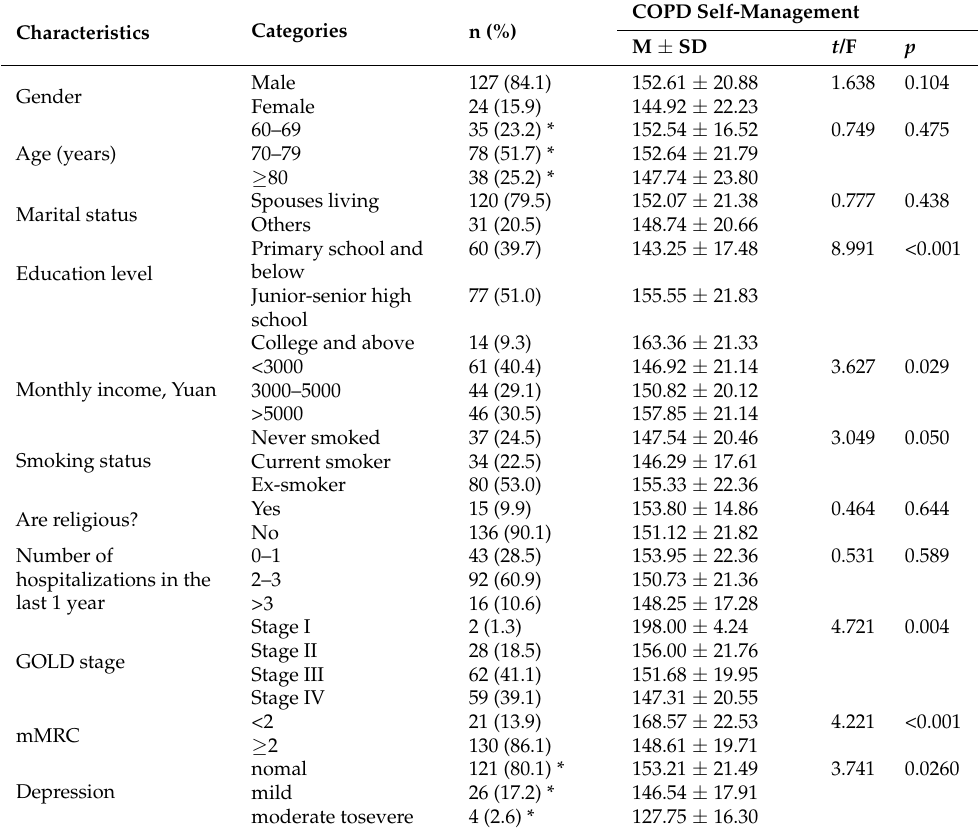
Table 1. Participant sociodemographic and clinical characteristics, differences of self-management level by